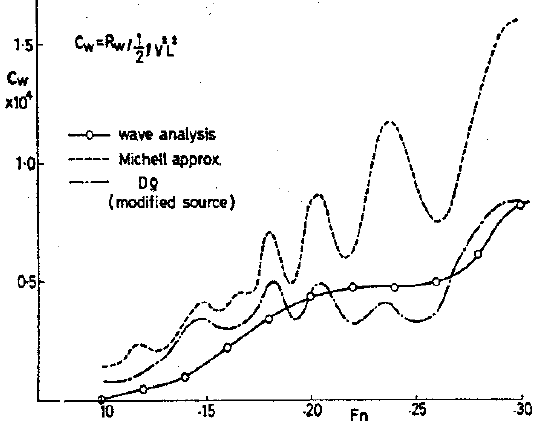
Figure 15. Comparison of ( a ) real and ( b ) calculated cross sections of Todd’s model. Points show calculated values.